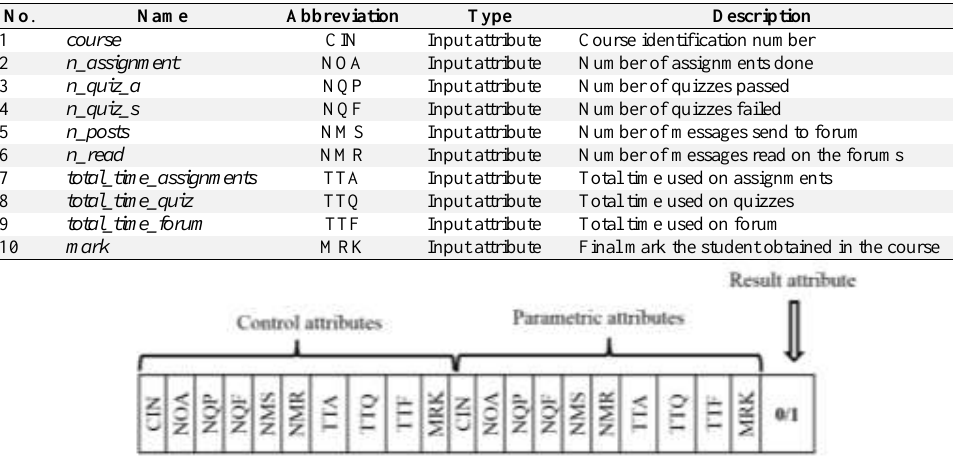
Table 4. Students’ attributes in summary file in Moodle system.